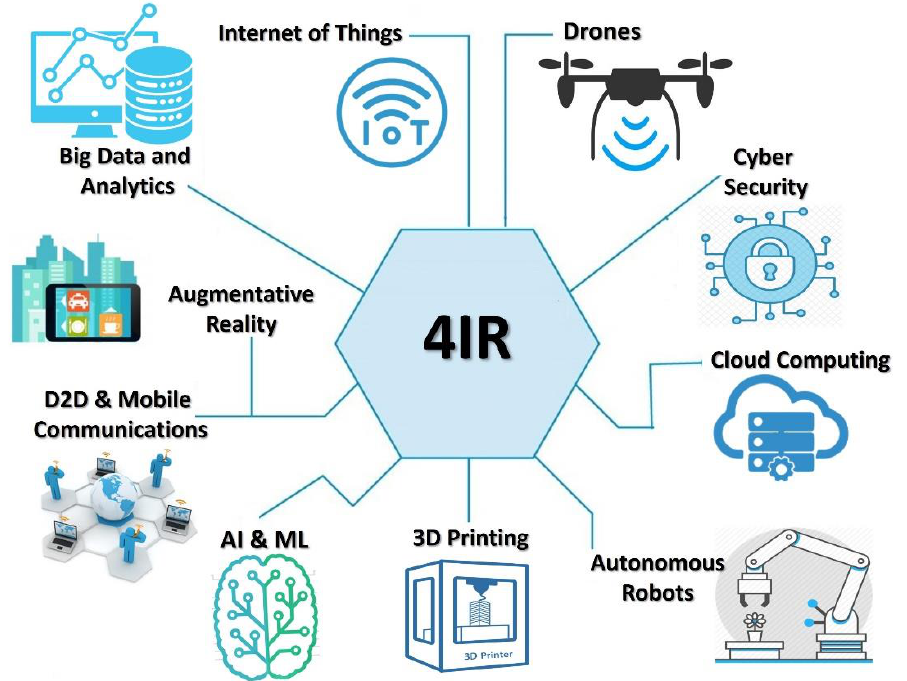
Figure 1. Technological pillars of the Fourth Industrial Revolution.